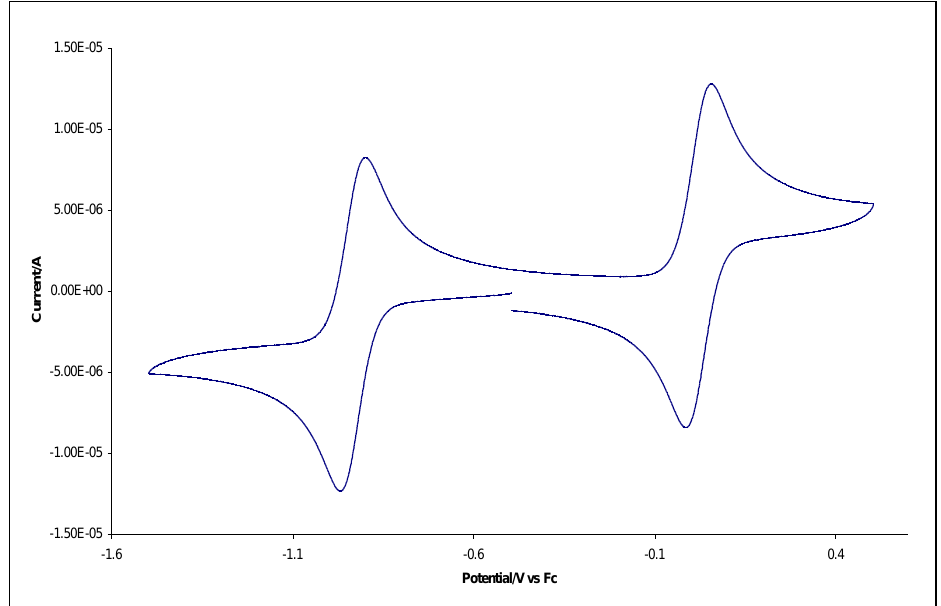
i Bu 2 CN 2 ) 2 ] in MeCN.